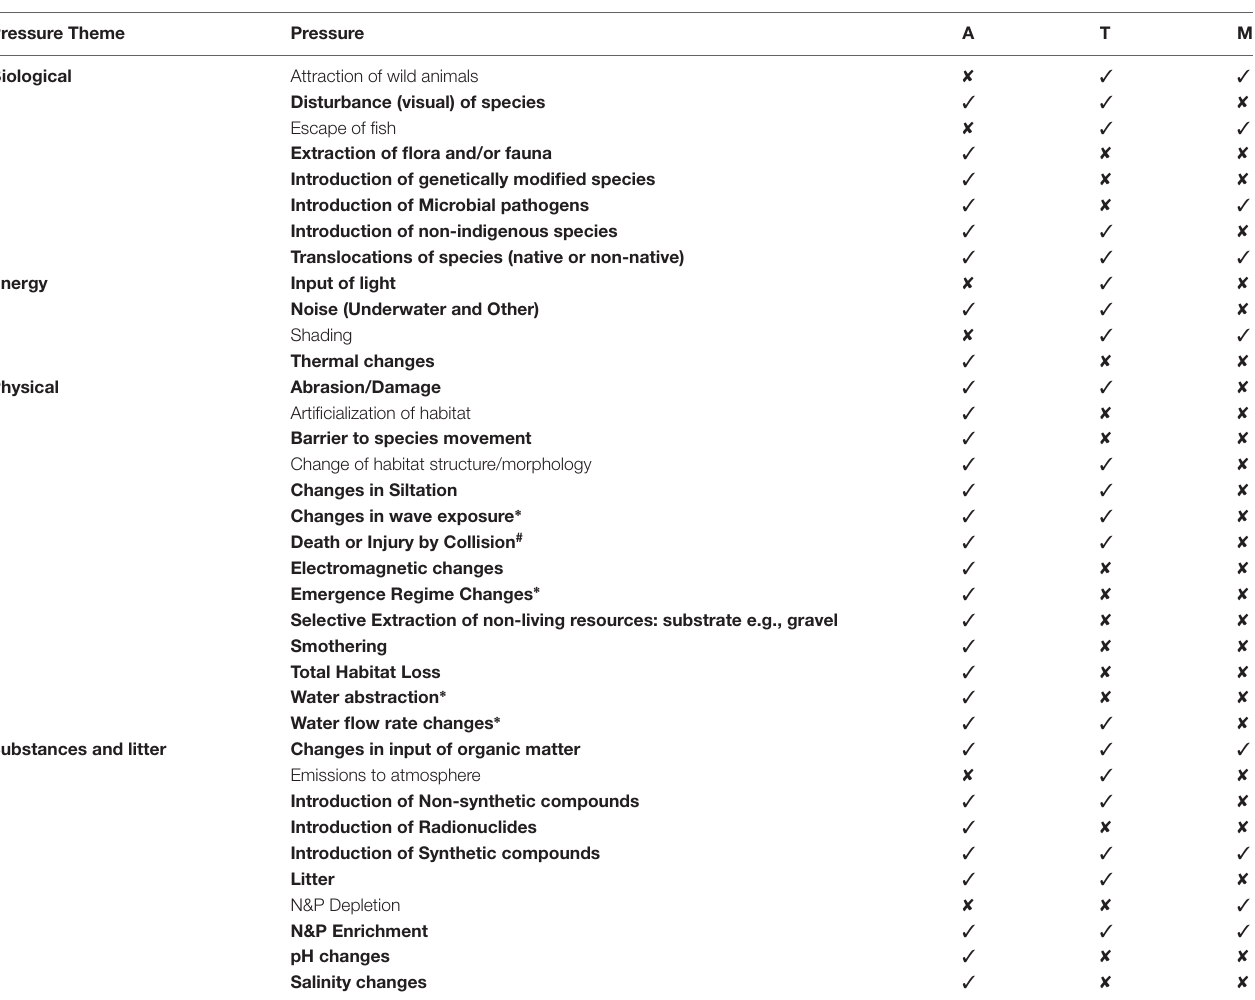
TABLE 2 | List of pressures identified for Space@Sea, categorized by pressure